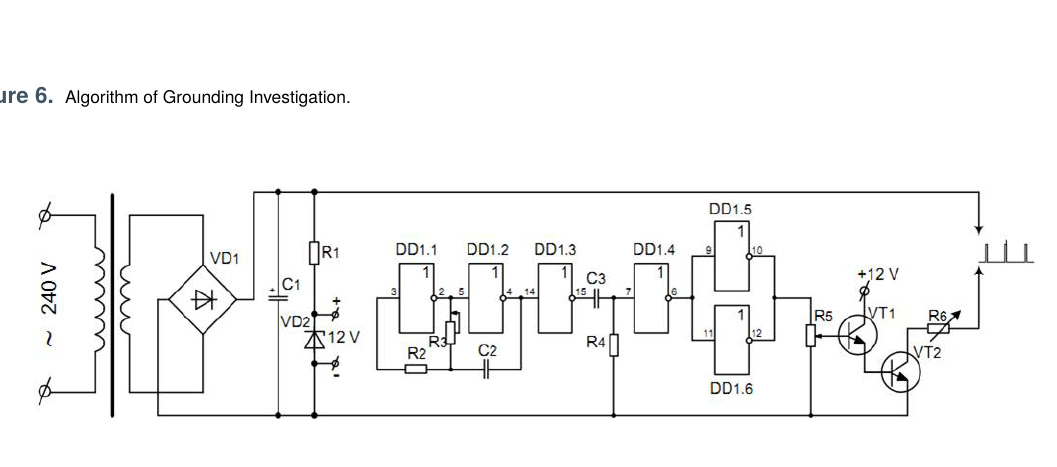
horizontal element and sends a signal to trigger the signal indicator ( SI ) if a damaged horizontal element of grounding is detected. The module also indicates a level of the captured signal above the horizontal element in order to find where it is located.